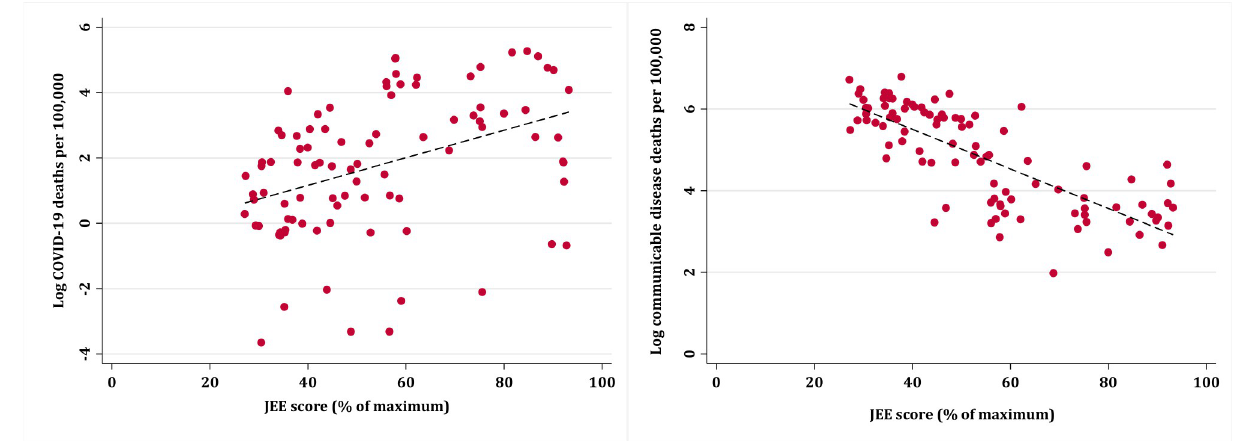
Fig 1. COVID-19 deaths (10 th March 2021) and communicable disease deaths (2019) by country Joint External Evaluation scores.